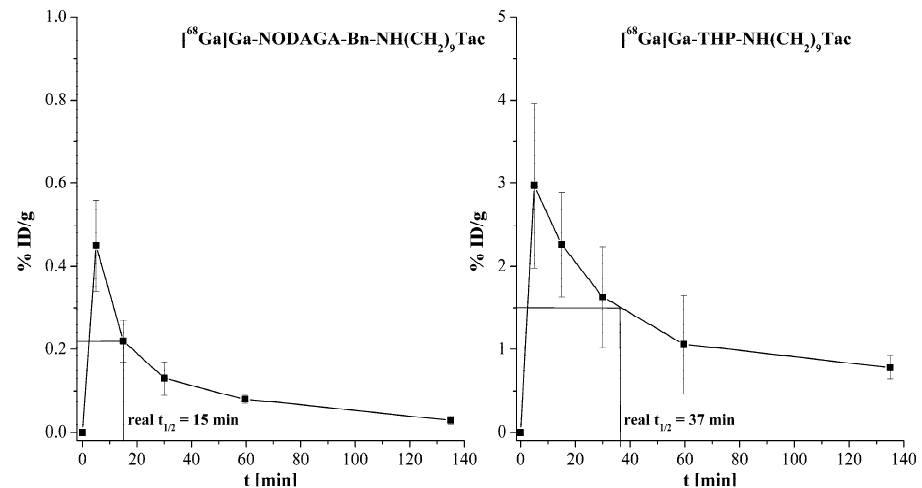
Figure 6. Results of [ 68 Ga]Ga ‐ NODAGA ‐ Bn ‐ NH(CH 2 ) 9 Tac and [ 68 Ga]Ga ‐ THP ‐ NH(CH 2 ) 9 Tac pharmacokinetics in blood samples determined by ex vivo radioactivity measurements, with effective (real) half ‐ lives of radioconjugates (15 min and 37 min, respectively) determined from the charts. To each plot an initial point of the coordinate system was added representing an absence of radioconjugate at 0 min time point.